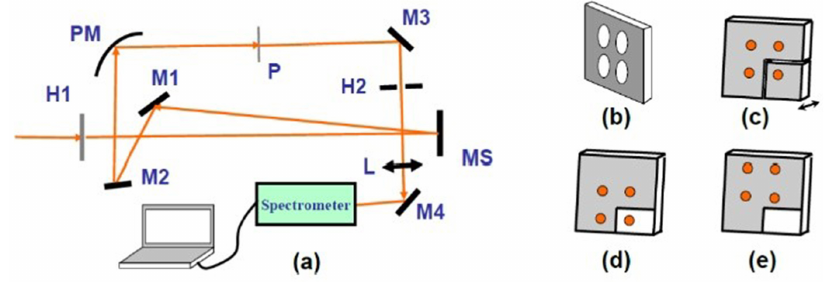
Figure 16. ( a ) Experimental setup for FASI; H1, black plate with four equal-sized holes, as shown in ( b ); MS, mirror set composed of an L-shaped mirror and a movable quarter mirror, as shown in ( c ); M1, plane mirror, which is five-sixths silver coated and can be moved up for SRSI measurement ( d ) or down for FROG measurement ( e ); M2–M4, silver-coated plane mirrors; PM, silver-coated parabolic reflector; P, 500- µ m-thick fused silica plate or 50- µ m-thick BBO crystal; H2, iris; L, lens. The red spots in ( c – e ) are the locations of the four incident beams on the mirrors [61].